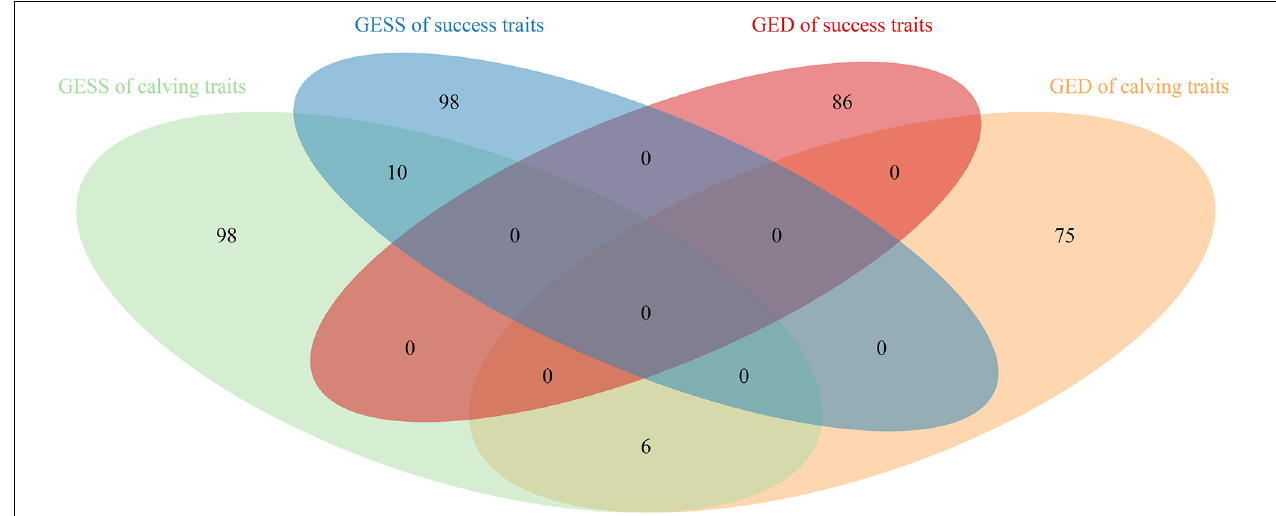
FIGURE 5 | Venn diagram of genes identified for the genetic effect of service sire and genetic effect of dam on success and calving traits in Holstein cattle.